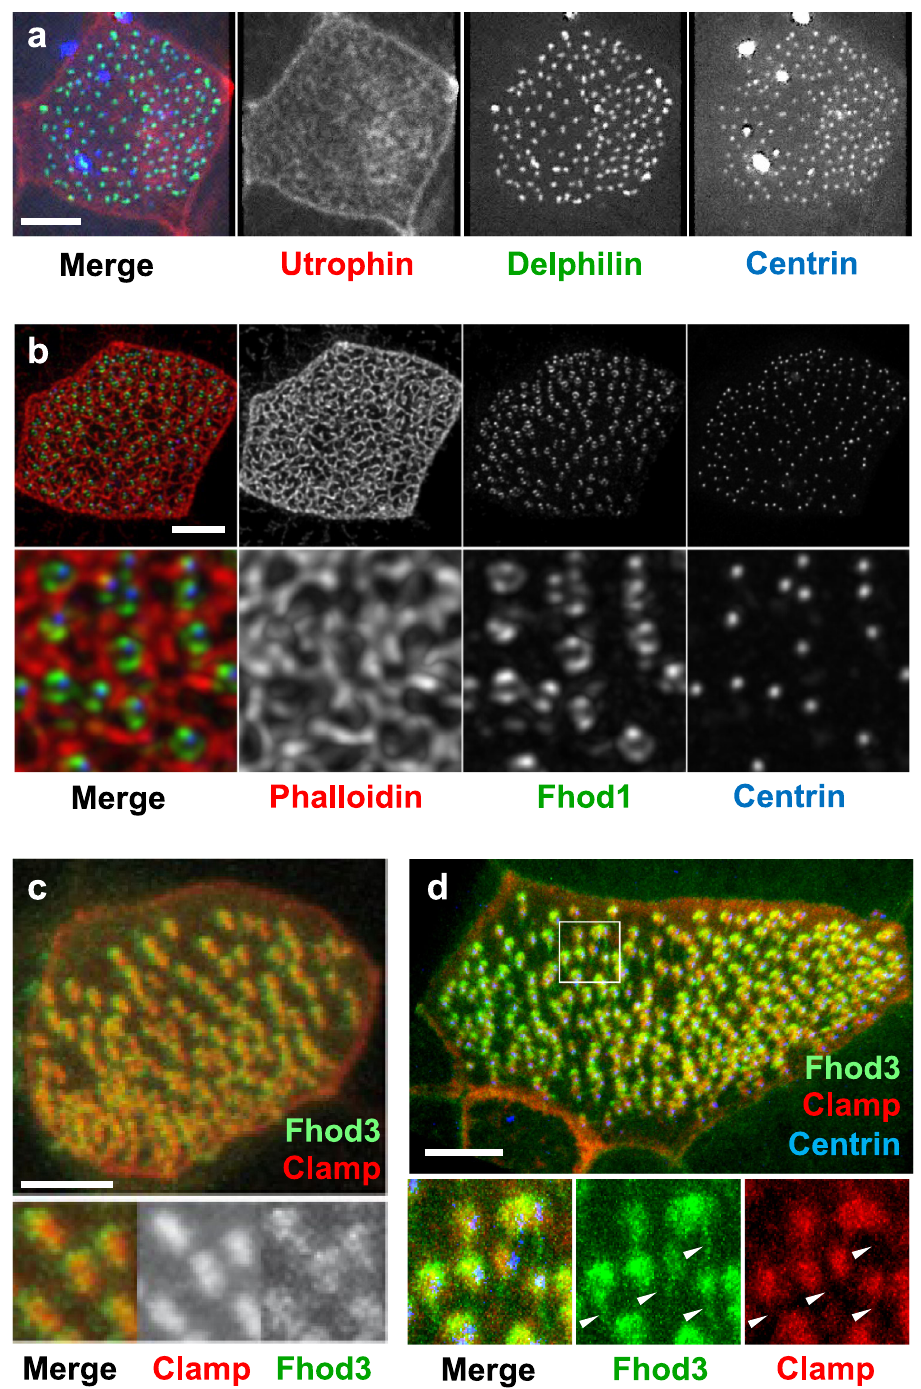
Fig. 3 Localization of Fhod3 in multiciliated cells (MCCs). a Delphilin, labeled with GFP, co-localizes with BFP-labeled Centrin to the basal bodies of MCCs. Actin fi laments were visualized by co-expression of RFP-Utrophin. b Fhod1 (GFP-Fhod1) assumes a position in between surrounding actin fi laments (phalloidin, red) and basal bodies (BFP-Centrin). c GFP-Fhod3 localizes to the tip of the RFP-Clamp-labeled anterior rootlet. The lower panel shows magni fi ed Clamp- and Fhod3-labeled images. d Fhod3 associates with anterior and posterior rootlets. The posterior rootlets (arrowheads) are oriented orthogonally to the plasma membrane. Depicted are diagonal views after 3D reconstruction of confocal images (IMARIS). Images were obtained at stage 29-30; scale bars, 5 µ domain 55 . Accumulation of PIP 2 in the inner lipid layer of out- the actin bundles outlining the microridges. Full-length Ezrin was ward concave membranes 56 can facilitate the recruitment and additionally found in the subapical actin layer, likely mediated by accumulation of Ezrin within microridges; alternatively, Ezrin has its C-terminal actin-binding domain that recognized actin fi la- been shown to bind to cytoplasmic domains of several membrane ments in the subapical compartment and/or interacted with proteins 57 . We found that the FERM domain of Ezrin localized to formin family members. Concomitant with the appearance of